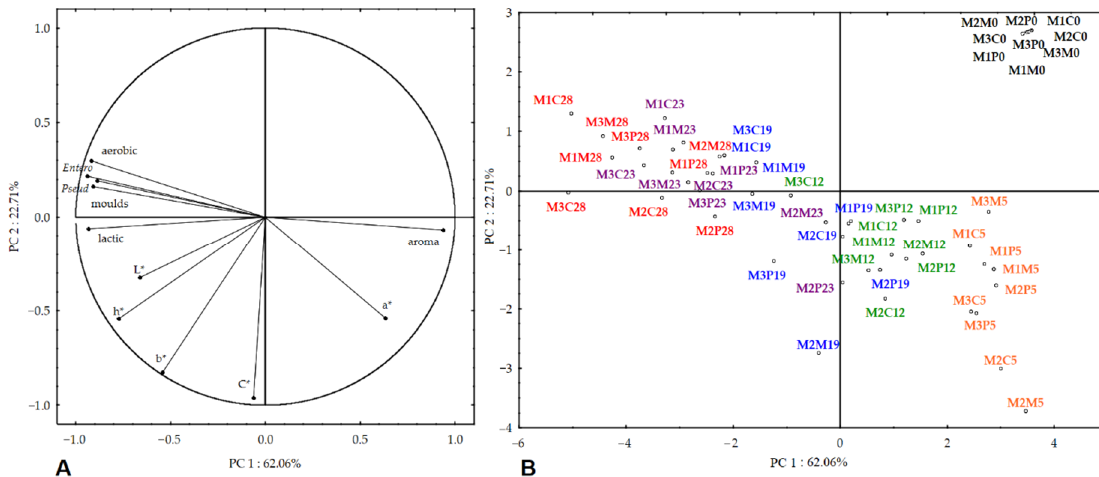
Figure 1. Quality attributes of pork with lysozyme packaged in modified atmosphere: ( A ): aerobic: aerobic plate count, Entero: Enterobacteriaceae , Pseudo: Pseudomonas , lactic: lactic acid bacteria, moulds: moulds and yeasts; ( B ): M1—65:25:10 O 2 :CO 2 :N 2 , M2—50:40:10 O 2 :CO 2 :N 2 , M3—80:20 O 2 :CO 2 ; C—control, M—monomer, P—modified lysozyme.